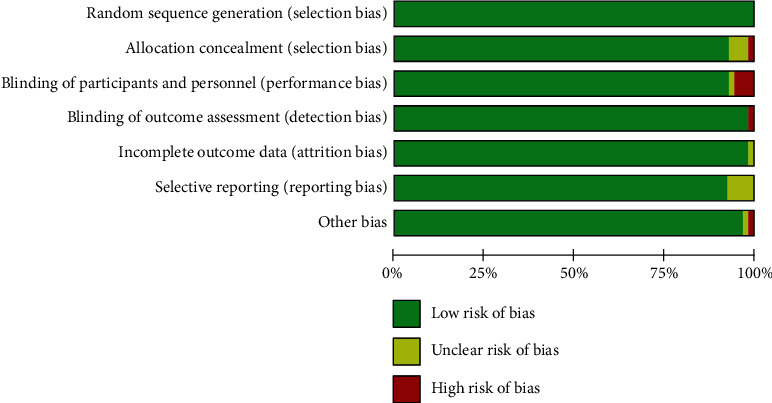
In vitro experiment quality evaluation results. This study included 52 articles with a low risk rate of more than 75 percent.